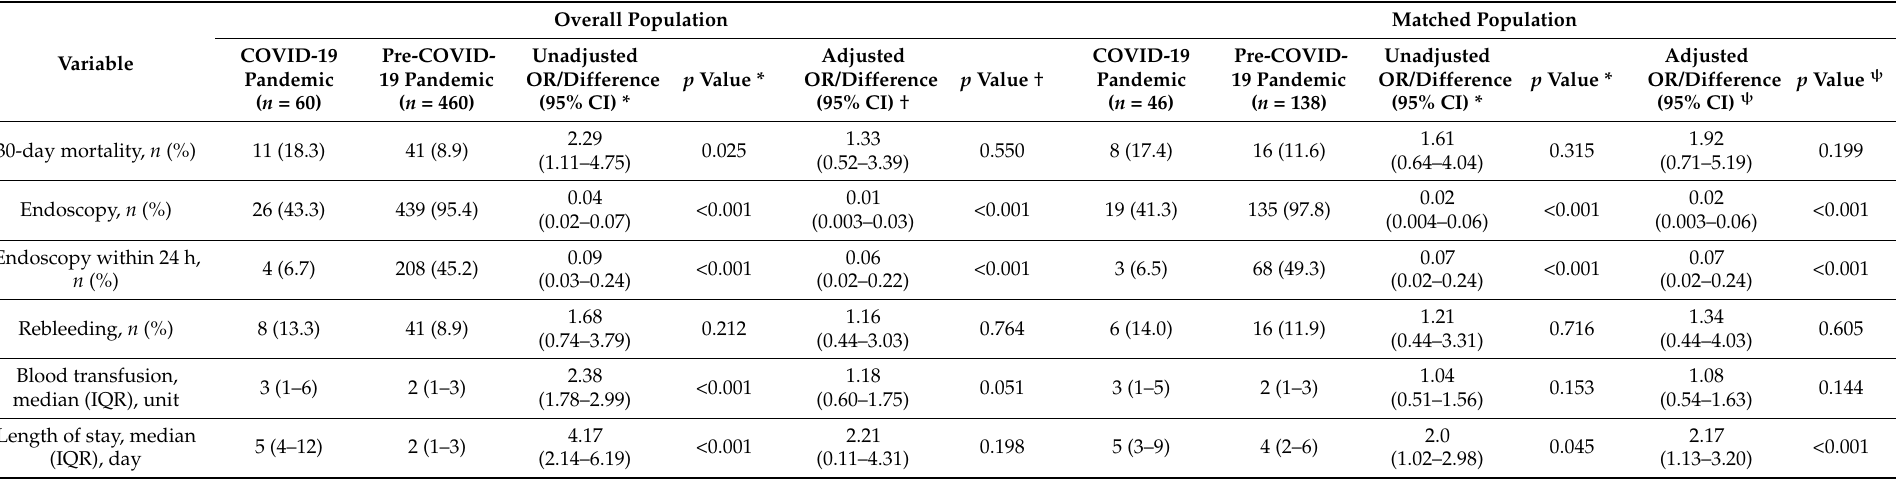
Table 4. Treatment outcomes for the overall and matched